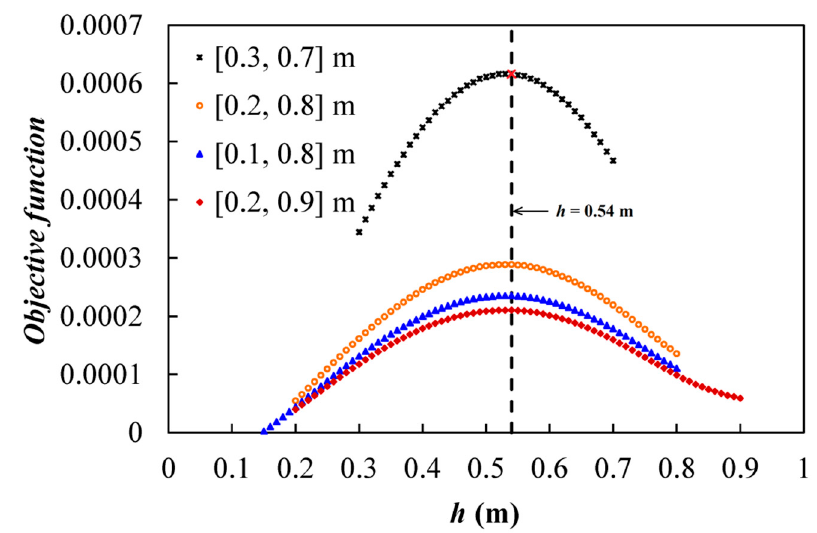
Figure 8. Comparison of relationships between the value of the objective function and the height of the weir ( h ) obtained from different h ranges.